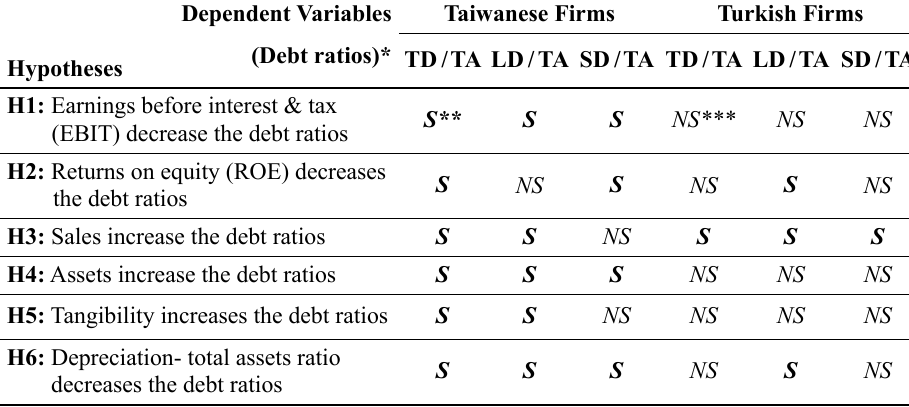
Table 6. Results of the hypotheses